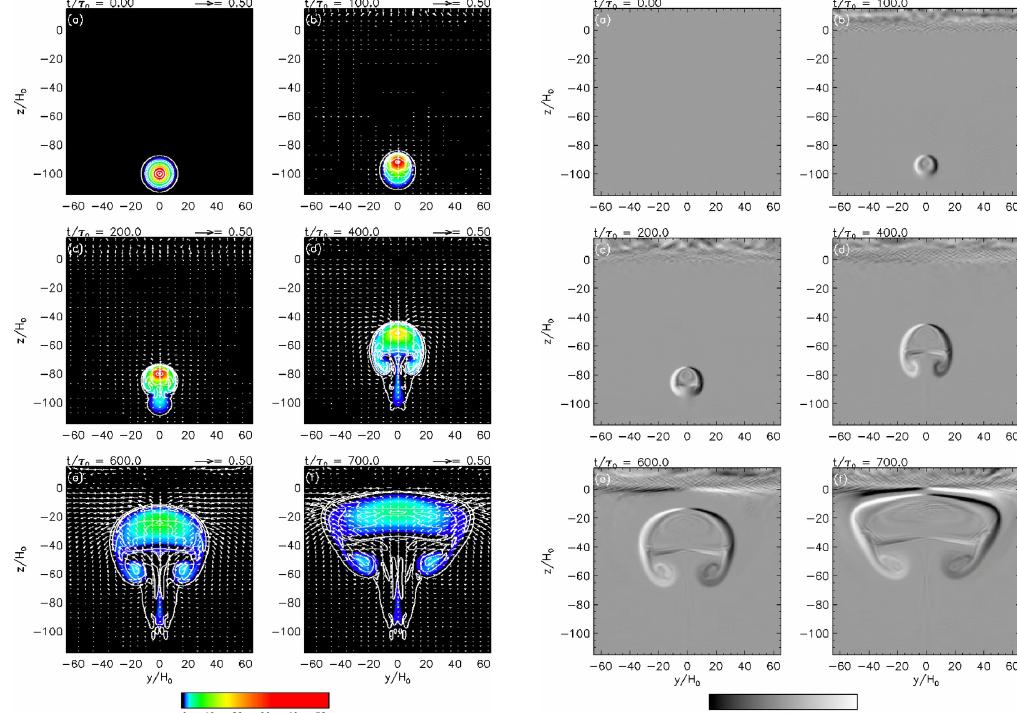
Figure 8: Sequence of snapshots from a 2D MHD simulation of the buoyant of a twisted buoyant flux tube through a polytropic model of the convection zone. The left and right panels show the magnetic field strength and out-of-plane component of vorticity, respectively. The top of the convection zone in this model is at 𝑧 = 0. Image reproduced with permission from Toriumi and Yokoyama (2011), copyright by